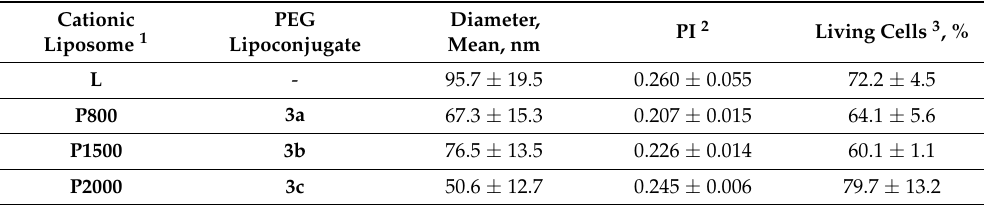
Figure 1 . Scheme of synthesis of lipoconjugates 3a – c ( a – c show the structure of spacer used) ( A ) and structures of cholesterol-based polycationic amphiphile 2X3 and lipid helper DOPE used for liposomes preparation ( B ). Reagents and conditions: ( i ) 4-NO 2 C 6 H 4 OCOCl and Et 3 N, 24 ◦ C, 11 h, then H 2 N-PEG-NH 2 , 24 ◦ C, 1 h, 57–73%; ( ii ) Ac 2 O, Py, 24 ◦ C, 6 h, 77–88%. Table 1. Hydrodynamic diameters, polydispersity index and cytotoxicity of PEG-containing cationic liposomes.